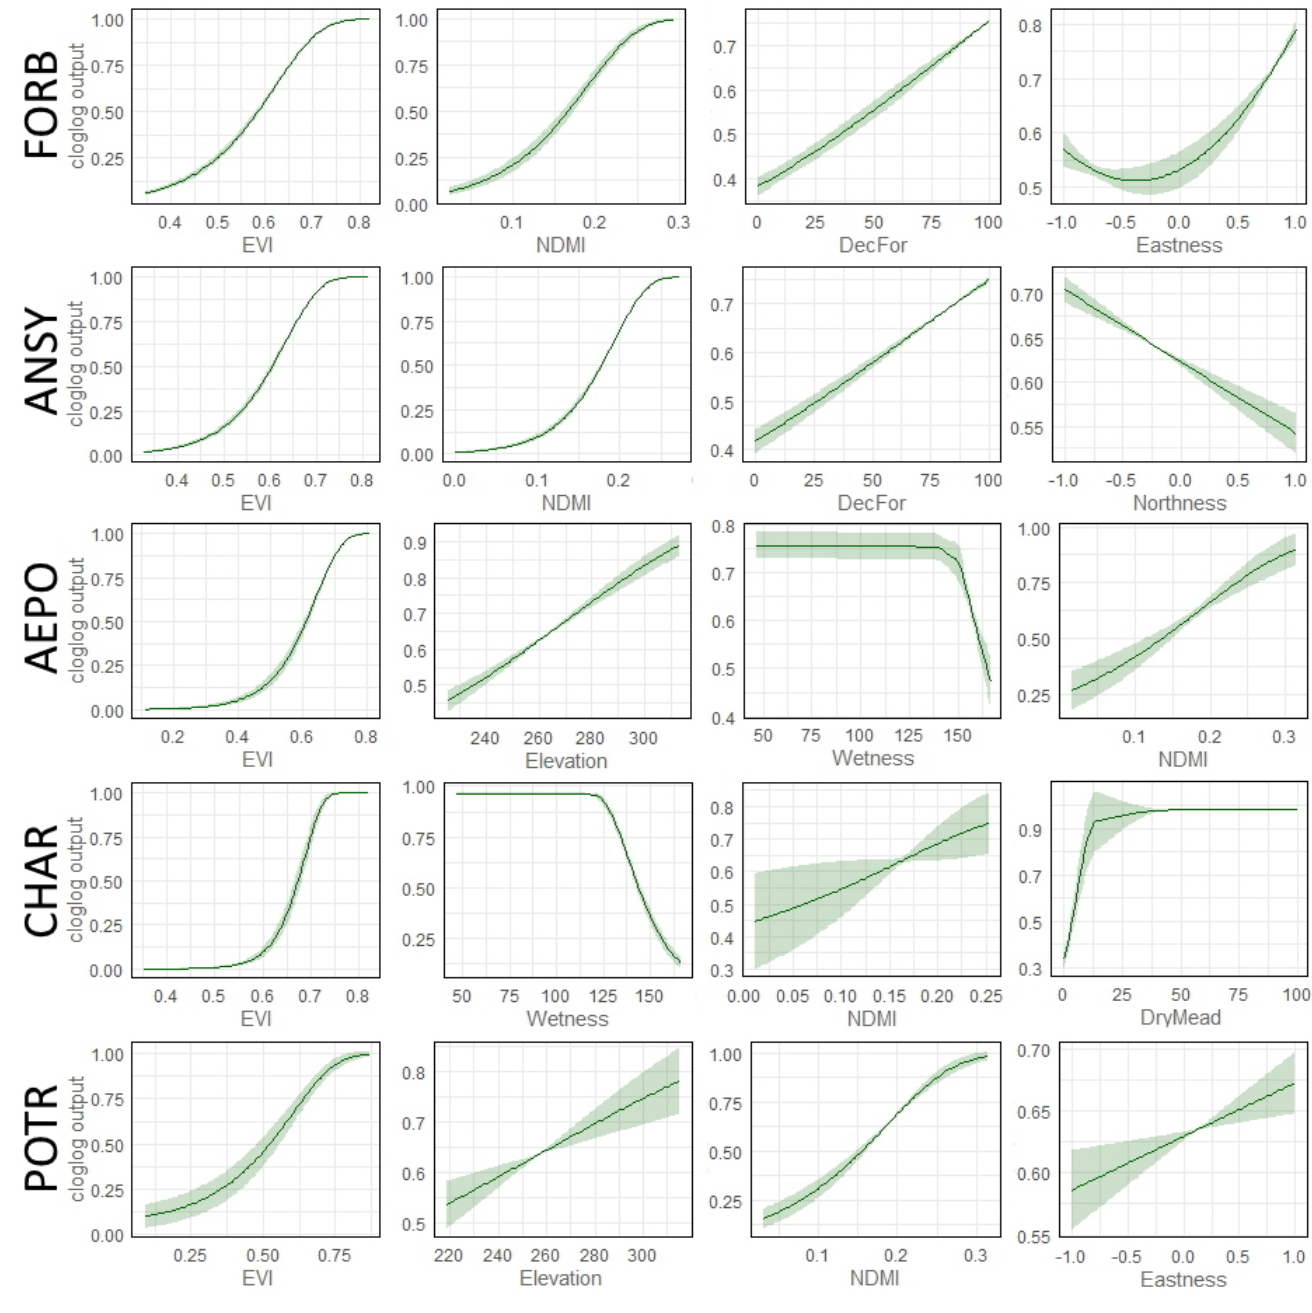
Figure A3. Response curves for the four most important variables of the brown bear vegetative food-probability models (forbs and tree leaves) in the Central Forest State Nature Reserve (West-European Russia) in 2008–2020. Designations: FORB— Apiaceae species, ANSY— Angelica sylvestris , CHAR— Chaerophyllym aromaticum , AEPO— Aegopodium podagraria , and POTR— Populus tremula . The curves show the mean response of the ten cross-validation MaxEnt runs and the mean ± one standard deviation. EVI—enhanced vegetation index; NDMI—normalised difference moisture index; Wetness—tasseled cap wetness; Elevation—elevation (m a.s.l.); Northness—northness (aspect) from the digital elevation model; Eastness—eastness (aspect) from the digital elevation model; SolRad—solar radiation; BorSpr—proportion of boreal spruce forests (%); DecFor—proportion of deciduous forests (mixed small-leaved forests) (%); DryMead—proportion of dry meadows (%). Units of the variables are shown in Table 1 of the main text.